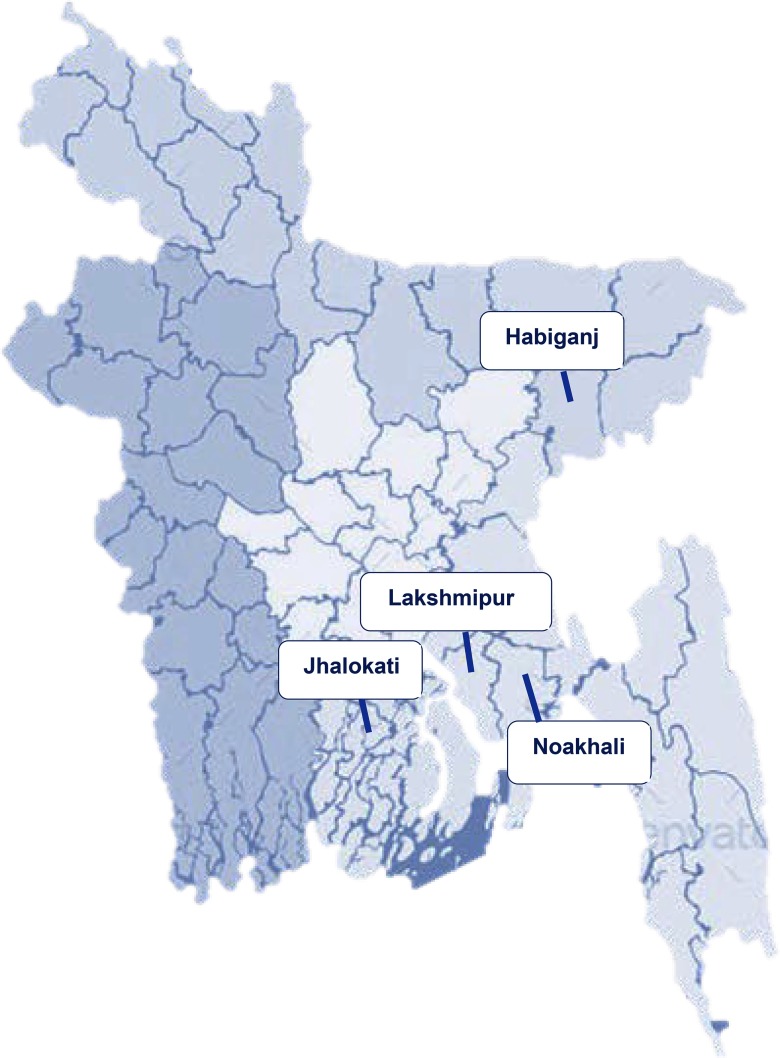
Map of Bangladesh Showing the Intervention Focus Districts